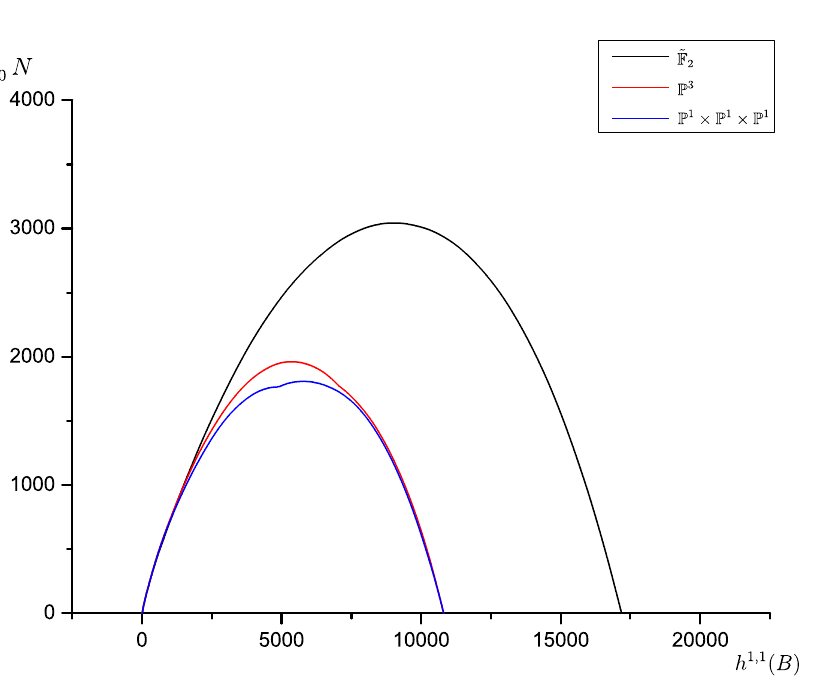
Figure 8 . Logarithm of the estimated number of resolvable bases as function of h 1 ; 1 ( B ) from blowing up P 3 , ~ F 2 and P 1 (cid:2) P 1 (cid:2) P 1 .